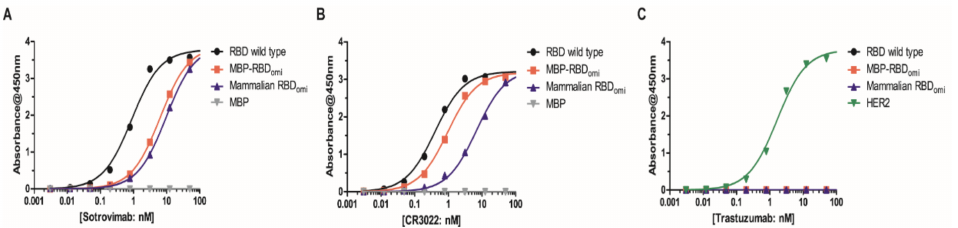
Figure 5. ELISA binding assay of E. coli -expressed MBP-RBD omi and mammalian cell-expressed RBDs to ( A ) sotrovimab, ( B ) CR3022, and ( C ) trastuzumab. MBP and HER2 were used as controls in this study. The black, red, blue, gray, and green dots indicate the absorbances of RBD wild type, MBP-RBD omi , mammalian cell-expressing RBD omi , MBP, and HER2, respectively. Error bars are ± standard deviation of triplicate experiments.